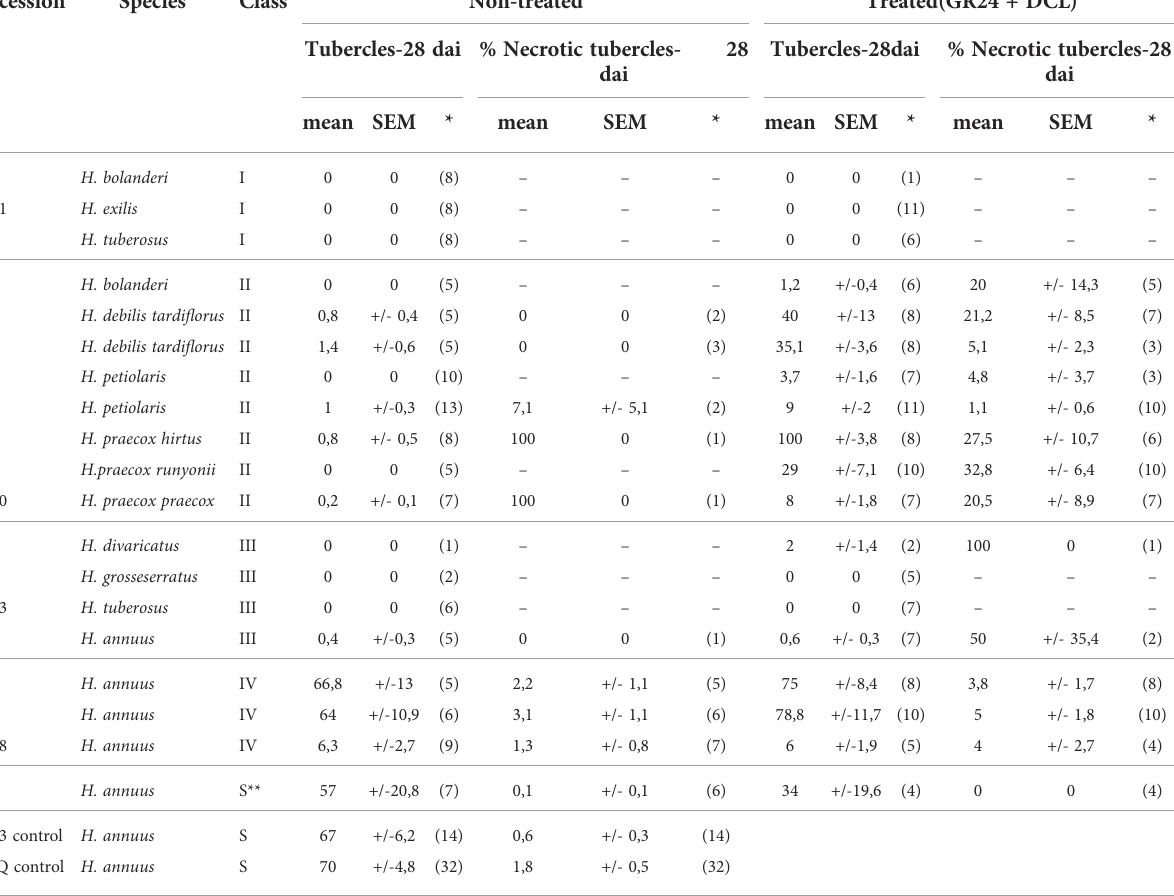
TABLE 4 Variability of the percentage of necrotic tubercles of 18 wild Helianthus accessions phenotyped in rhizotrons at 28 dai, using the broomrape race E-BOU.